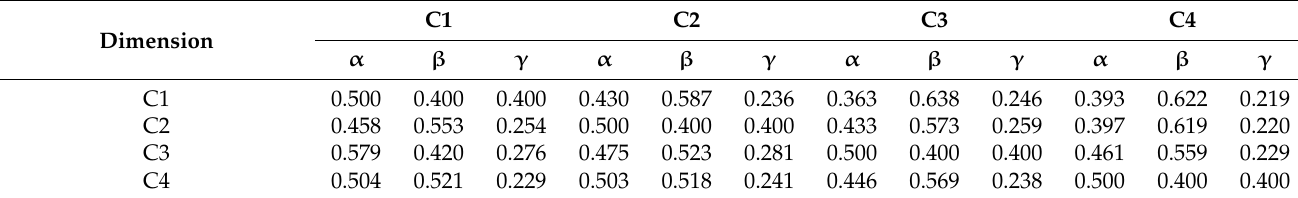
Table 10. The spherical weights from SF-AHP.